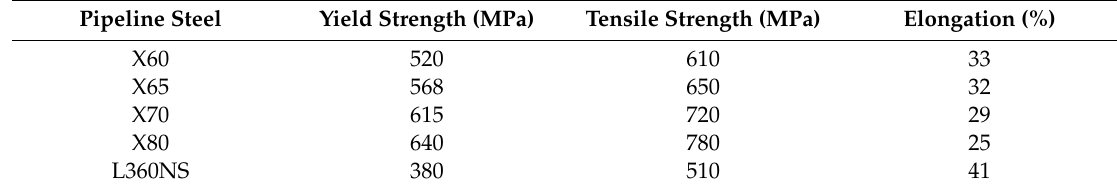
Table 2. Mechanical properties of API X60, X65, X70, X80 and L360NS pipeline steels [8–10]. Pipeline